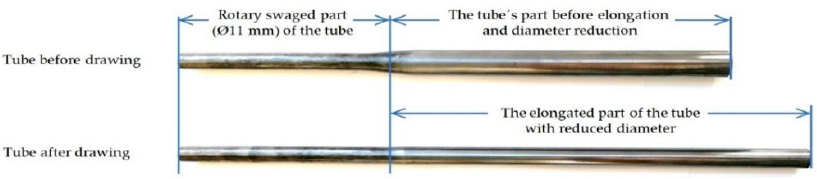
Figure 4. The shape of the tube before and after drawing. Table 9. Chemical composition of E235 steel (wt %).